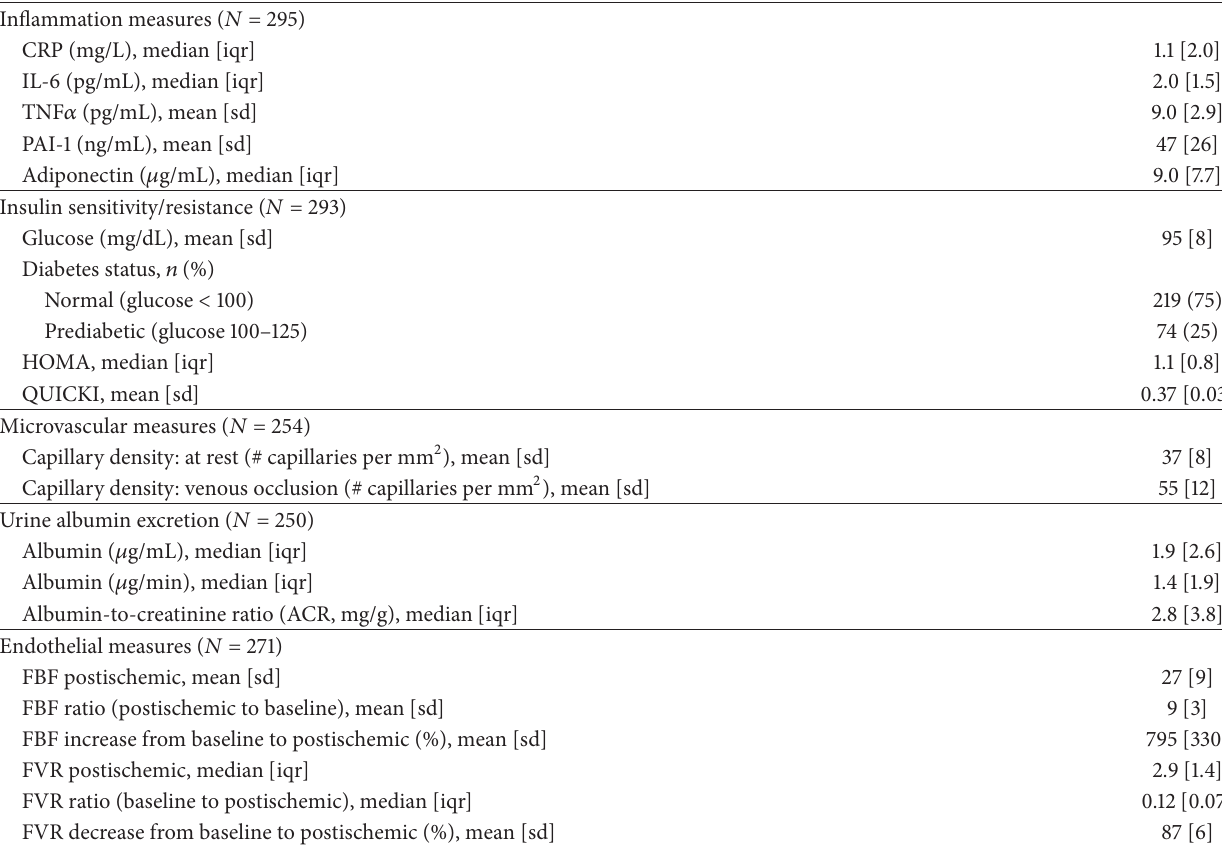
Table 2: Summary of inflammation measures ( 𝑁 = 295), insulin sensitivity/resistance ( 𝑁 = 293), microvascular measures ( 𝑁 = 254), urine albumin excretion ( 𝑁 = 250), and endothelial measures ( 𝑁 = 271 ).